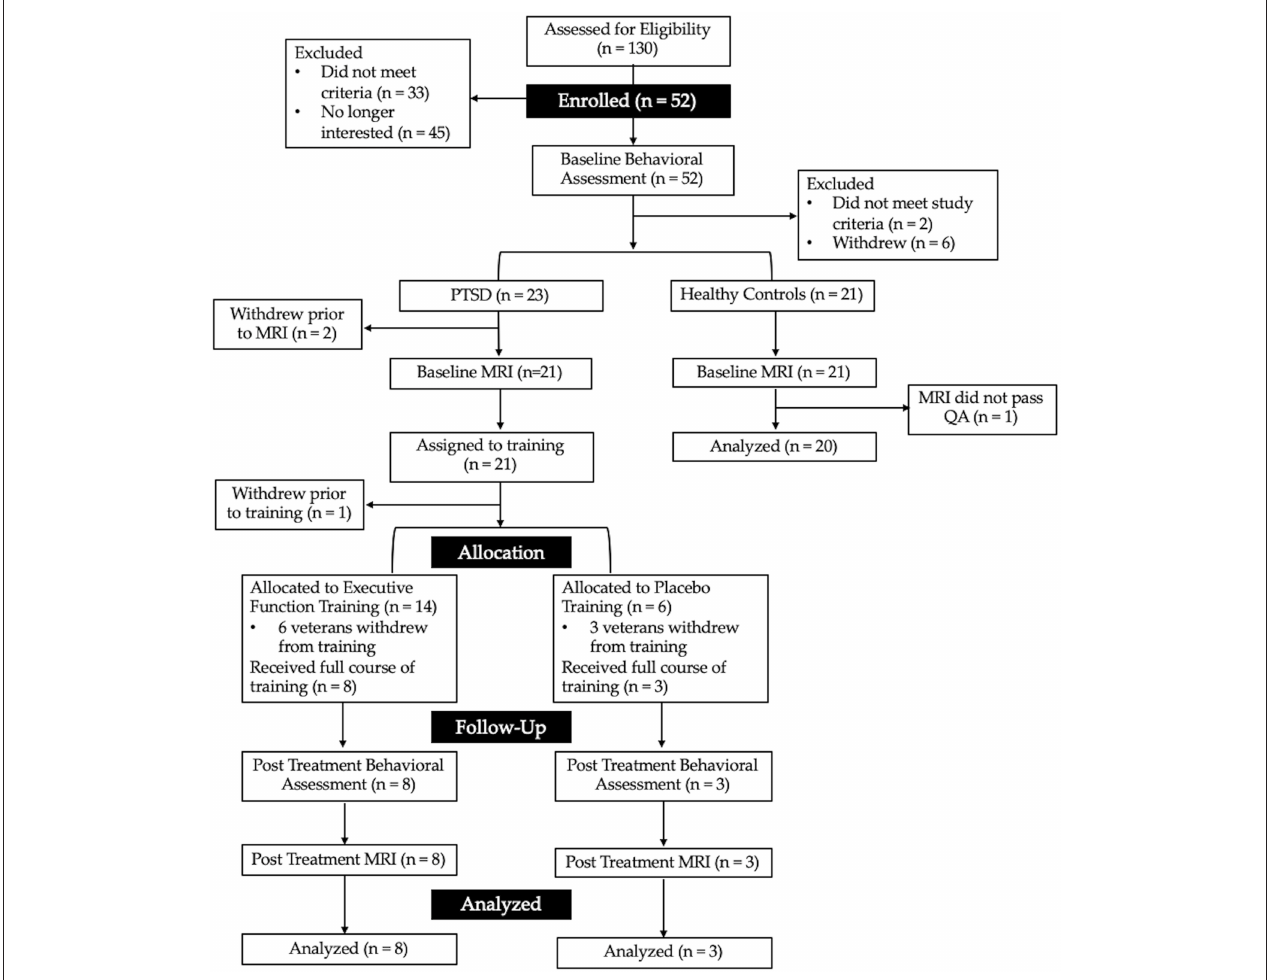
FIGURE 1 | CONSORT diagram showing the flow of recruitment and retention for the present study. Interested veterans completed a phone screen to determine initial eligibility for the baseline behavioral assessment. Veterans were then assigned to either the combat-exposed control group (those without a current mental health disorder) or those with post-traumatic stress disorder (PTSD). Those with PTSD were assigned to 6-weeks of either executive function or active placebo